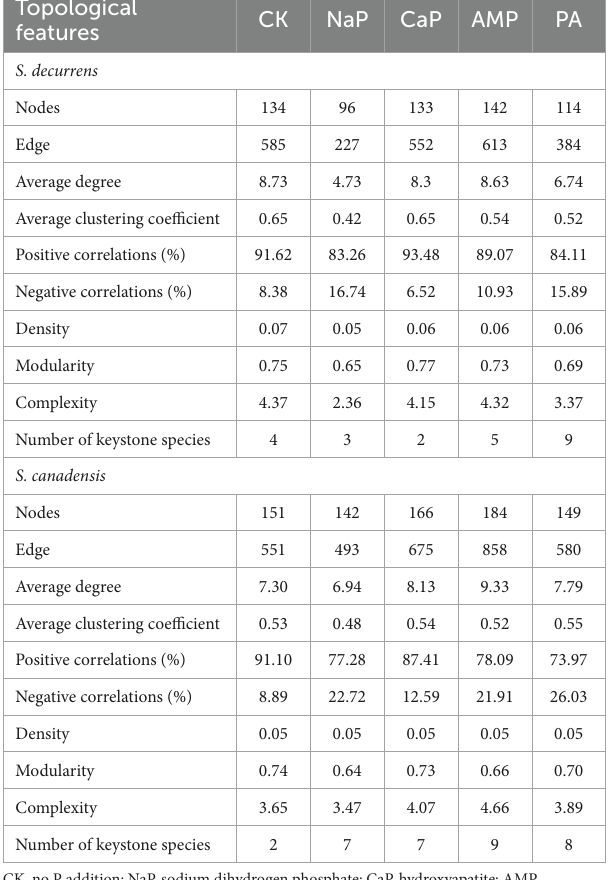
TABLE 2 Topological features of the AMF co-occurrence network of two Solidago species under five P treatments. Topological